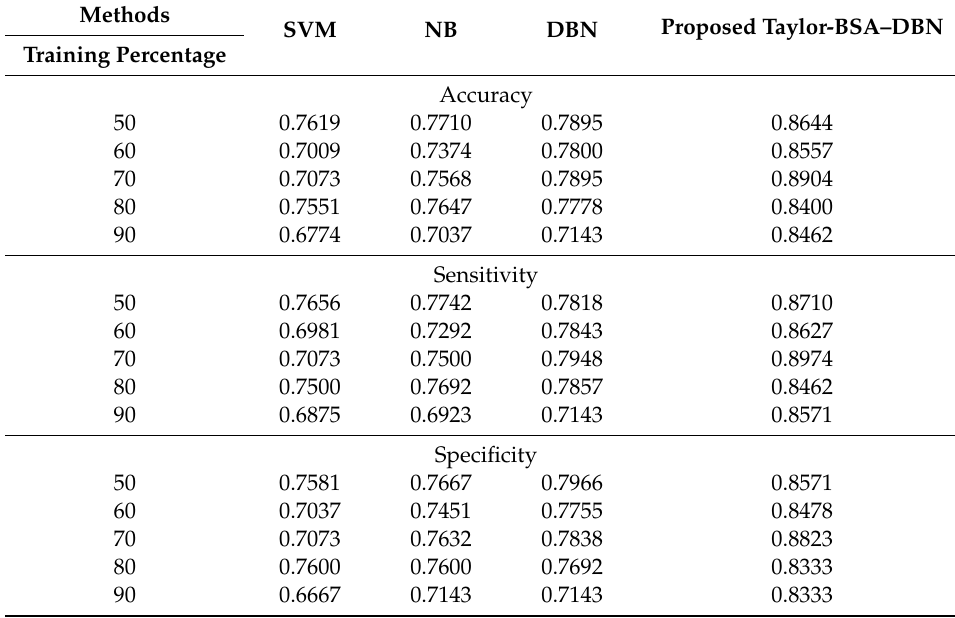
Table 4. Analysis of methods with cluster size = 5 using the Switzerland